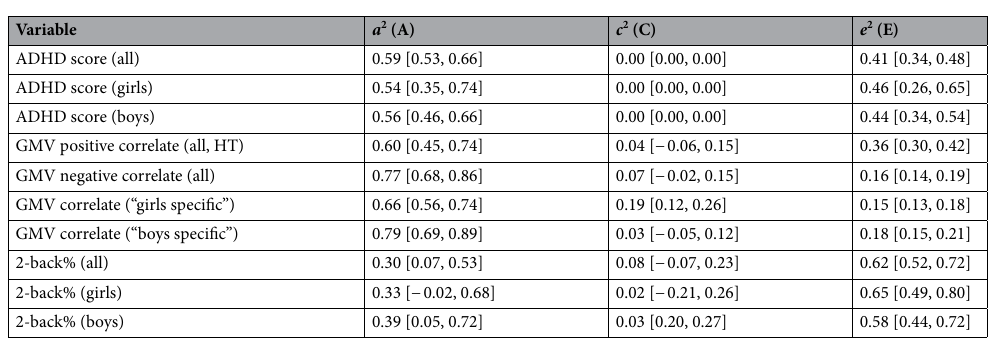
Table 1. Genetic, shared environmental, and non-shared environmental effects of ADHD scores, GMV correlates, and 2-back%. HT: hypothalamus; a 2 : proportion of variance due to additive genetic effects (A); c 2 : proportion of variance due to shared environmental effects (C); e 2 : proportion of variance due to non- shared environmental effects (E); 95% confidence intervals are presented in square brackets. Age, sex (only for “all”), study site, and race were included as covariates, and scanner model and TIV were included as additional covariates for GMVs. Only 9,982 children, with 500 MZ and 2,208 DZ had N-back task